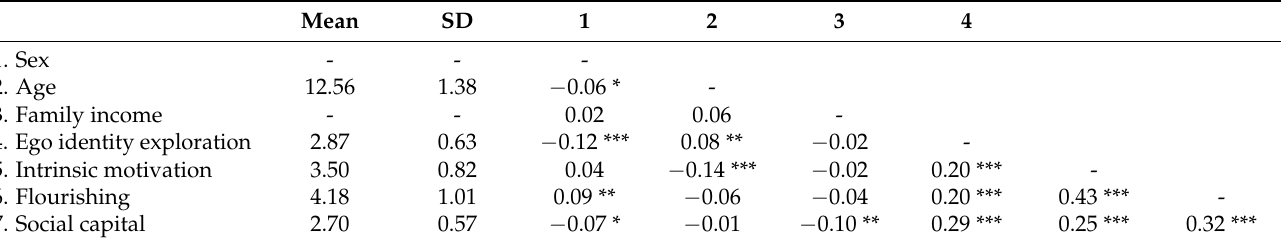
Table 1. Descriptive statistics and bivariate correlations in variables (N =